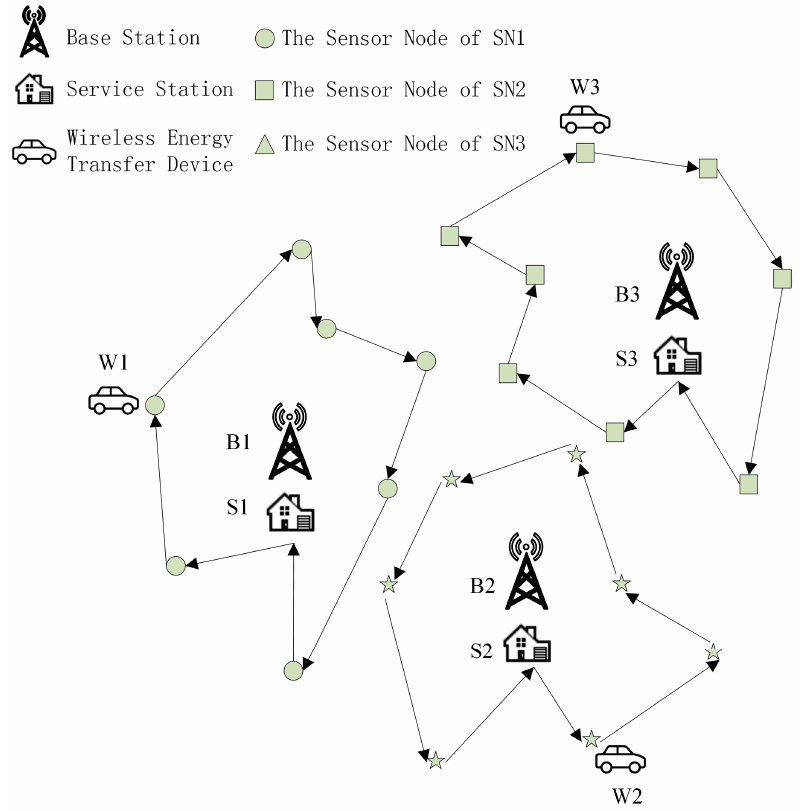
Figure 2. The wireless sensor network divided into 3 sub